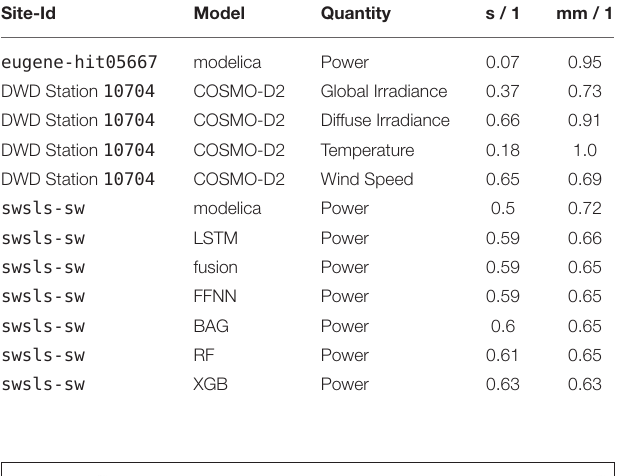
TABLE 4 | Forecast performance for 2019 in terms of s and mm .